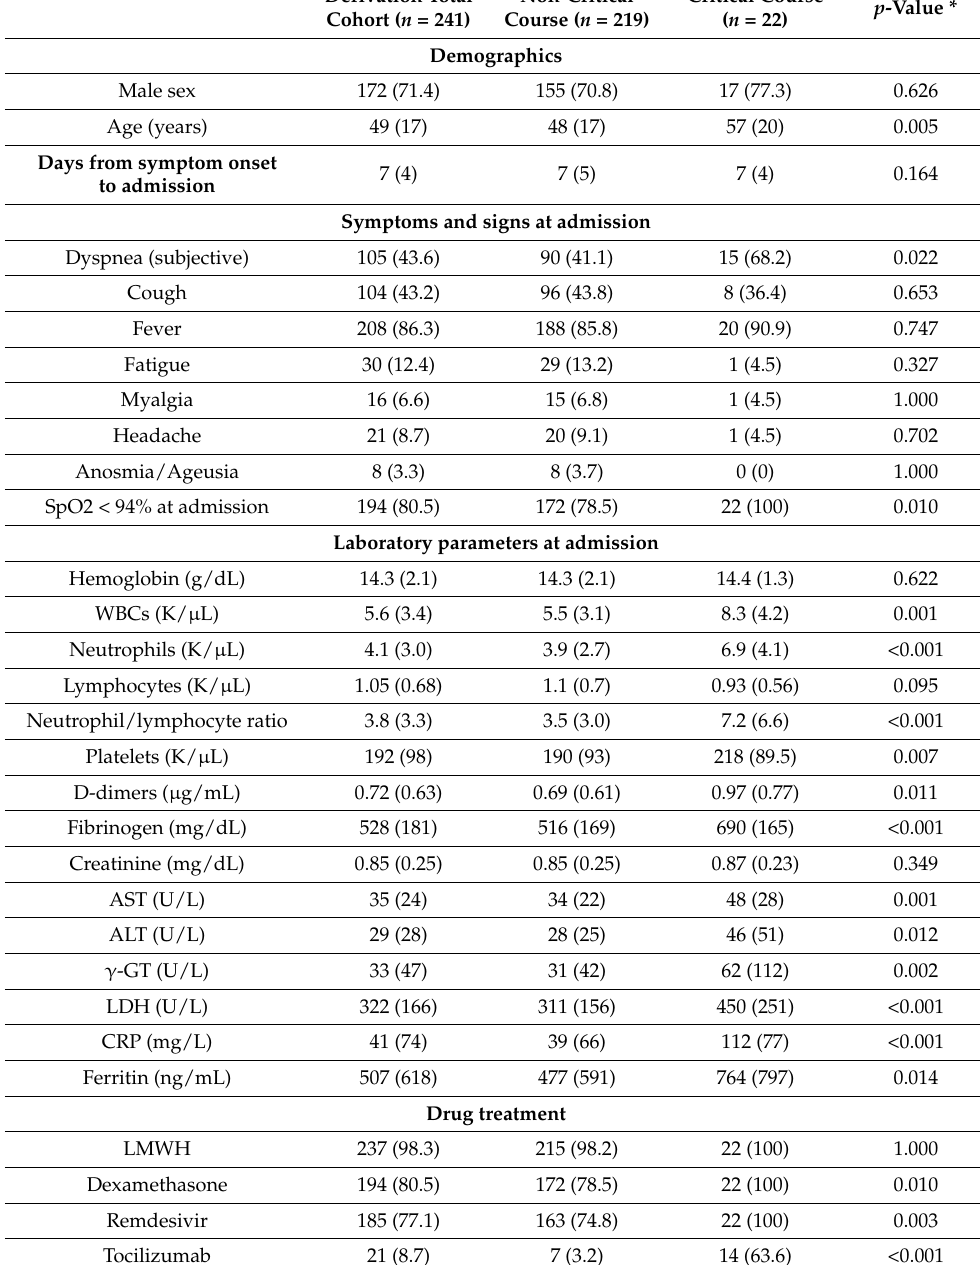
Table 1. Characteristics of the derivation study cohort at hospital admission, stratified also by the subsequent need of high-flow oxygen and/or intubation (critical disease